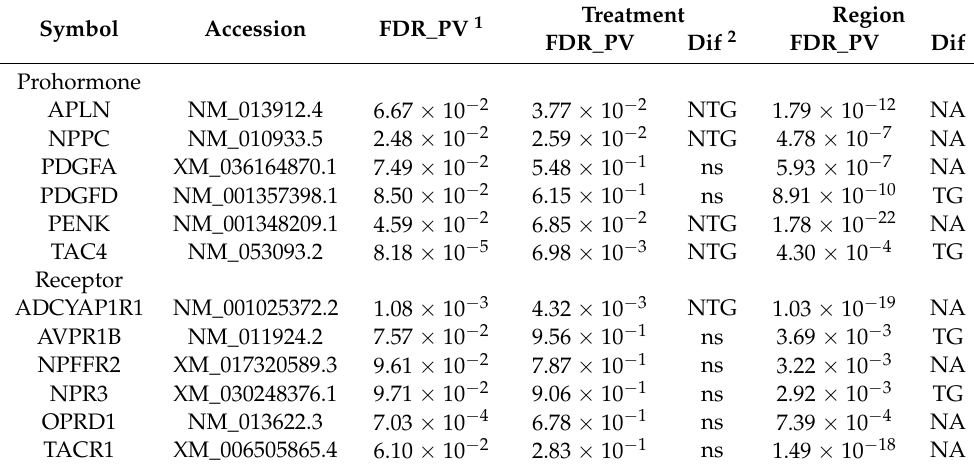
Table 1. Neuropeptide prohormone and receptor transcript isoforms and genes that present sig- nificant (FDR-adjusted p -value < 0.05) effect of nitroglycerin-elicited hypersensitivity to pain in a region-dependent (treatment-by-region) manner.